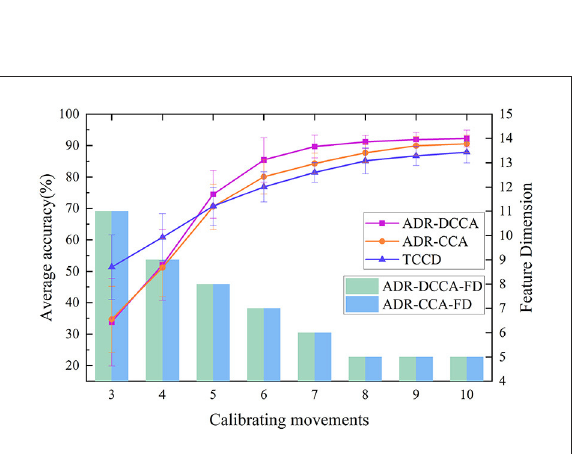
FIGURE8 Relationships between sample size and classification accuracy and between sample size and new feature dimensions. ADR-DCCA and ADR-CCA denote the classification accuracy of the ADR-DCCA architecture and ADR-CCA with different numbers of calibration sets, respectively. ADR-DCCA-FD and ADR-CCA-FD are the corresponding feature dimensions under classification accuracy. TCCD indicates the classification accuracy when training the classifier model directly with the calibration dataset.